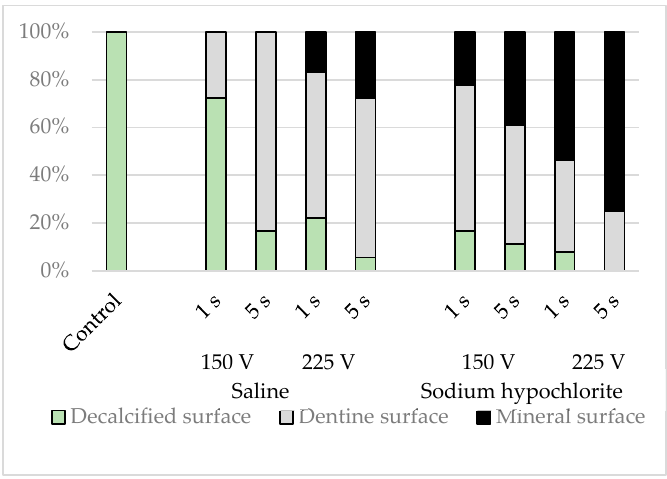
Figure 8. Classi fi cation results for simulated root canal walls by elemental analysis. Figure 8. Classification results for simulated root canal walls by elemental